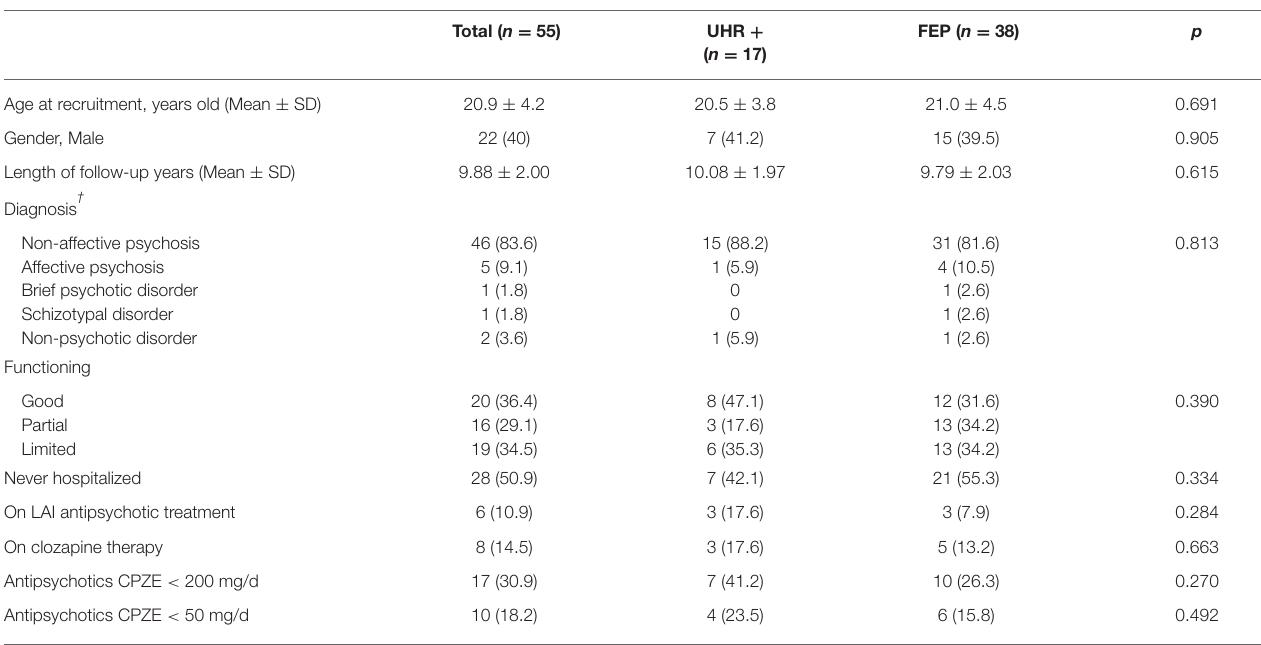
TABLE 2 | Clinical characteristics of patients with follow-up for more than 5